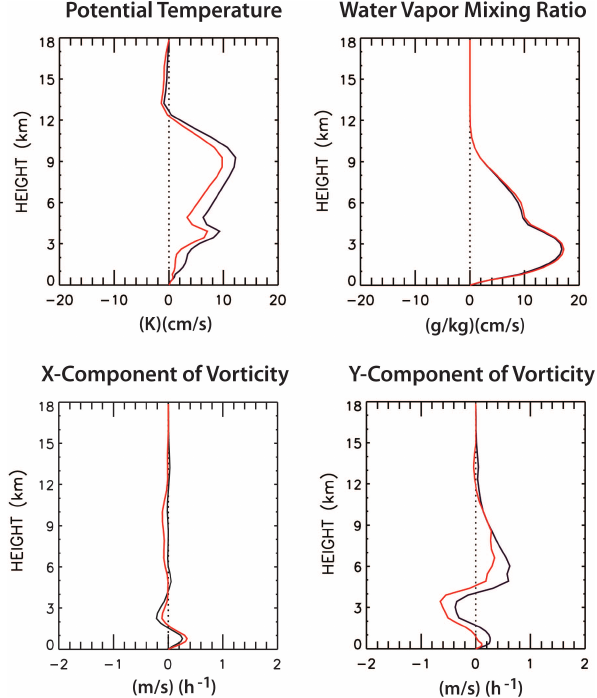
Fig. 14. Vertical profiles of the time- and domain-averaged vertical transports of potential temperature, water vapor mixing ratio, and the horizontal components of vorticity by the Q3-D CRM (red lines) and by the BM (black